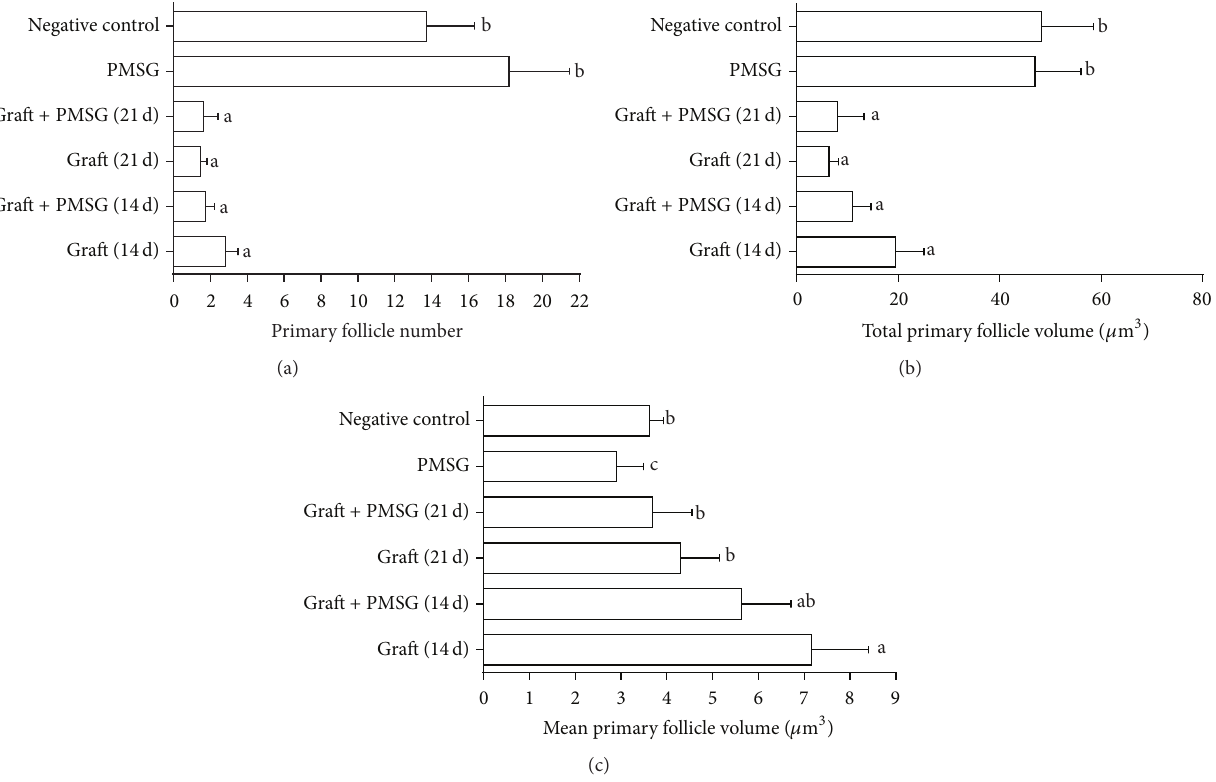
Figure 3: Mean and standard error of histomorphometric analysis of primary follicles (a) total number, (b) total volume, and (c) mean follicle volume in control group, pregnant mare serum gonadotropin (PMSG) group, transplantation (14 and 21 d), and PMSG/transplantation (14 and21d)groupsafterautologousovariantransplantationandsuperovulatoryeffectofPMSG. a , b , c Differentsuperscriptlettersshowsignificant difference between different groups ( 𝑃 < 0.05